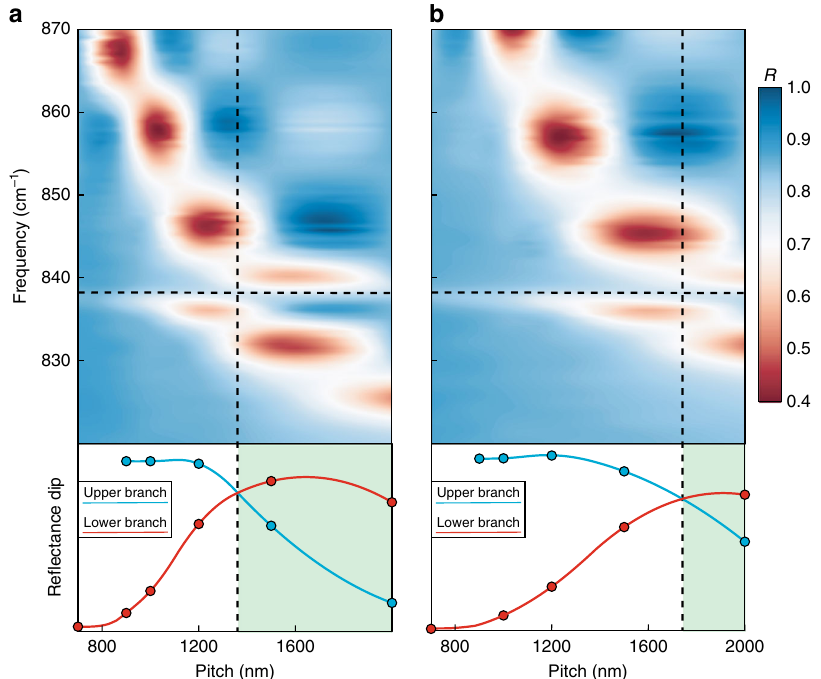
Fig. 3 Experimental demonstration of strong coupling between a ZFLO and the monopolar mode of a nanopillar array. Upper panels illustrate the experimental re fl ectance from an array of 4H-SiC nanopillars with diameter ( a ) 300 nm ( b ) 500 nm and height 950 nm recorded as a function of the lattice period. The horizontal dashed line indicates the weak phonon resonance. The lower panel shows the magnitude of the re fl ectance dip extracted from the data. The shaded region indicates the region where the upper polariton is predominantly LO in character, demarcated by the vertical dashed